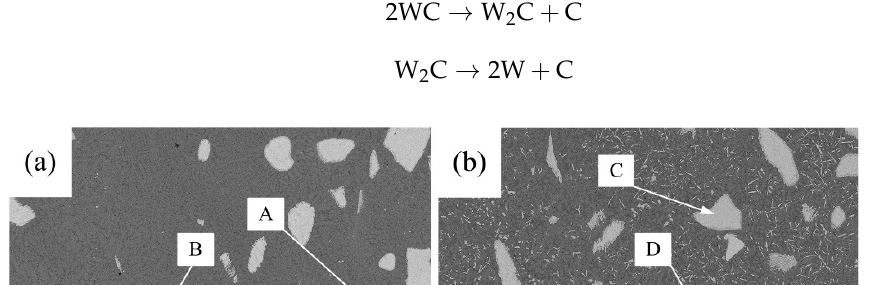
These two elements then react with other elements in a molten pool to form differently shaped carbides during the cooling stage [21].